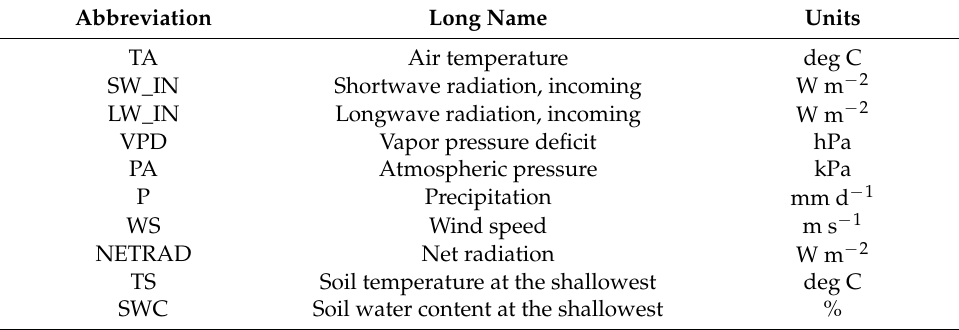
Table 1. Summary of input features for the model